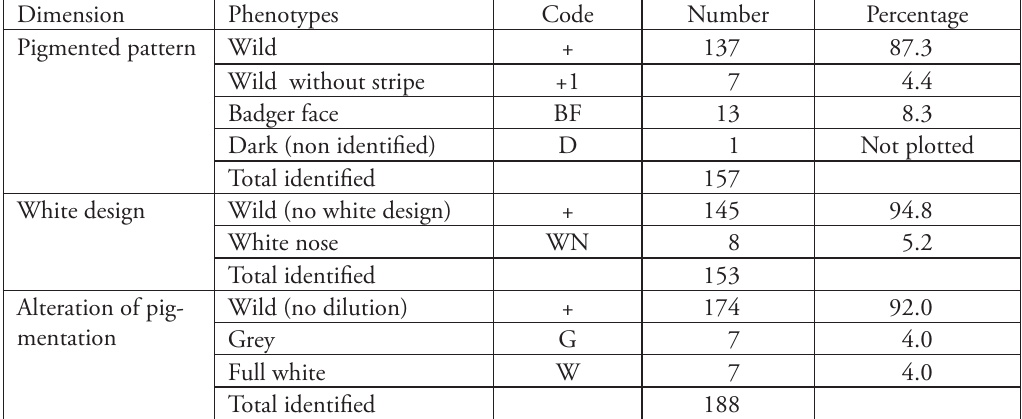
Table 2. Phenotypic frequencies in 3 dimensions (pigmentary pattern, white designs, alteration of pigmen- tation) in the Ahvenjärvi